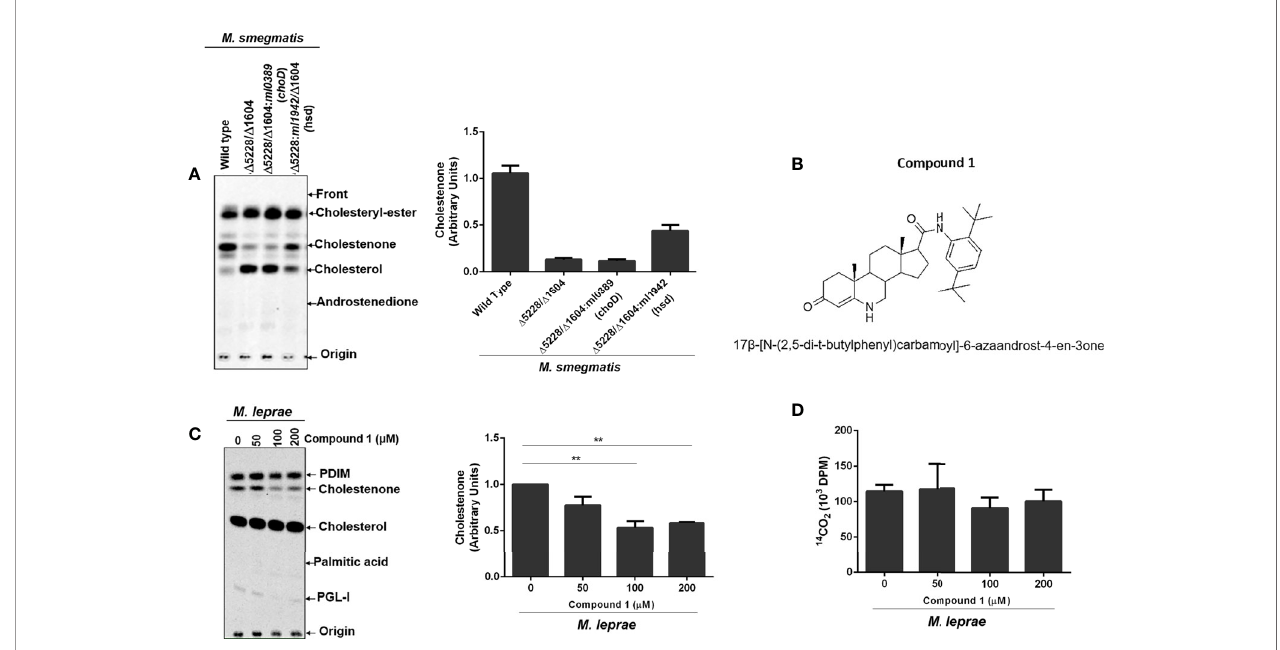
FIGURE 2 | M. leprae 3 b -HSD is the enzyme responsible for converting cholesterol into cholestenone. (A) Representative thin-layer chromatography (TLC) plate in silica G60 plates of Wild type (WT) M. smegmatis , hsd/choD double mutant ( D 5228/ D 1604) and double mutant complemented with either M. leprae choD ( D 5228/ D 1604:ml0389) or hsd ( D 5228/ D 1604:ml1942) were cultured in MSM-ty medium and incubated with [ 14 C]cholesterol for 30 min to assess cholestenone production using petroleum ether-ethyl acetate 1:1 (v/v) as mobile phase. Corresponding densitometry for cholestenone is presented on the right (n=2). Reference standards: Cholesteryl-Ester; cholesterol; cholestenone; and Androstenedione. (B) Structure of compound 1, 17 b -[N-(2,5-di-t-butylphenyl)carbamoyl]-6-azaandrost-4-en-3one. (C, D) M. leprae was incubated with increasing concentrations of compound 1 for 1 h in Middlebrook 7H9 broth supplemented with 2% DMSO at 30°C. 1µCi/mL of [26- 14 C]cholesterol and 1µCi/mL of [1- 14 C]palmitic acid were added to mycobacterium suspensions and incubated for additional 48 h at 33°C. (C) Lipid extracts obtained from mycobacterial cells by chloroform-methanol 2:1 (v/v) extraction were analyzed by TLC using chloroform-methanol 95:5 (v/v) as mobile phase. Radiolabeled lipids were observed in the PhosphorImager. Representative of 3 experiments and corresponding densitometry of cholestenone is depicted on the right. The cholestenone detection was determined using reference standards PDIM; cholesterol; cholestenone; palmitic acid and PGL-I. (**p < 0.01 - ANOVA test followed by Bonferroni as a post-test were performed and used for statistical analyses) (n=3). (D) M. leprae viability after compound 1 treatment was measured by radiorespirometry assay